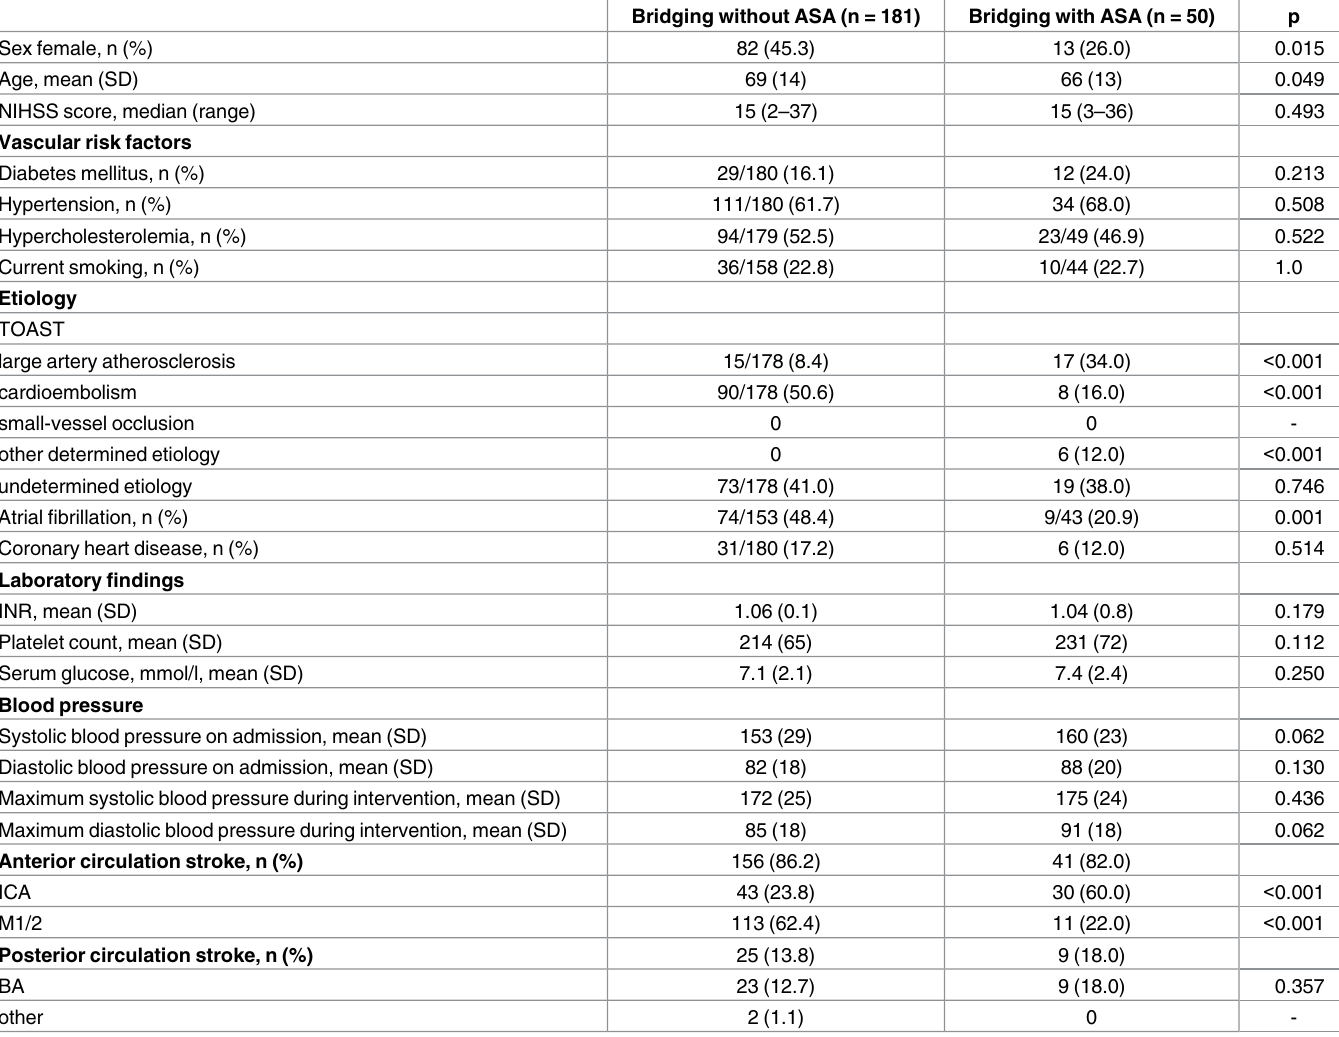
Table 1. Baseline characteristics and vascularrisk